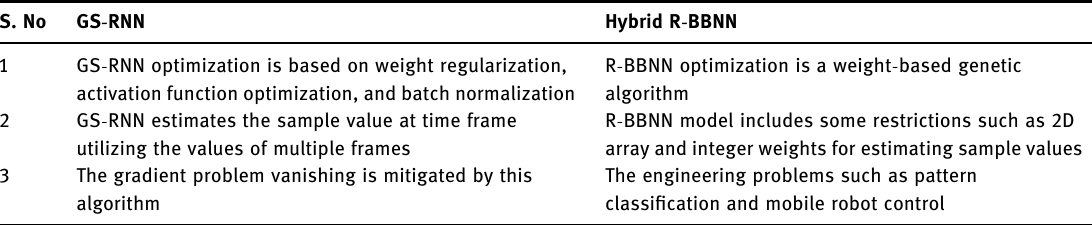
Table 1: Comparison of GS - RNN and the hybrid R -